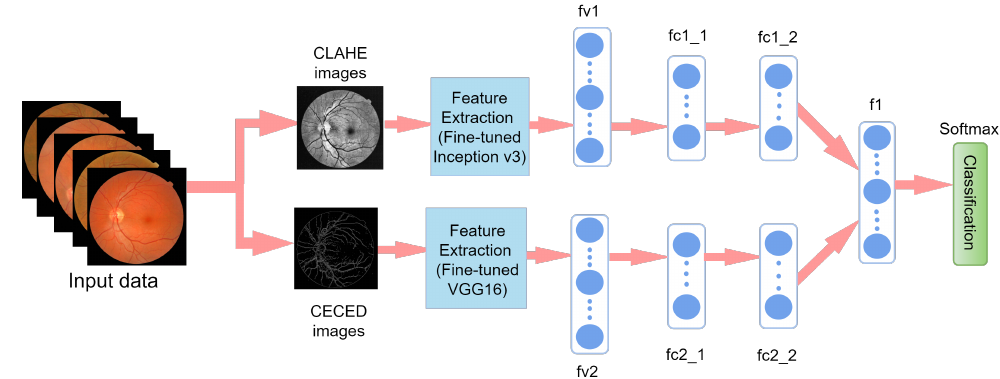
Figure 7. Our proposed weighted fusion deep learning network